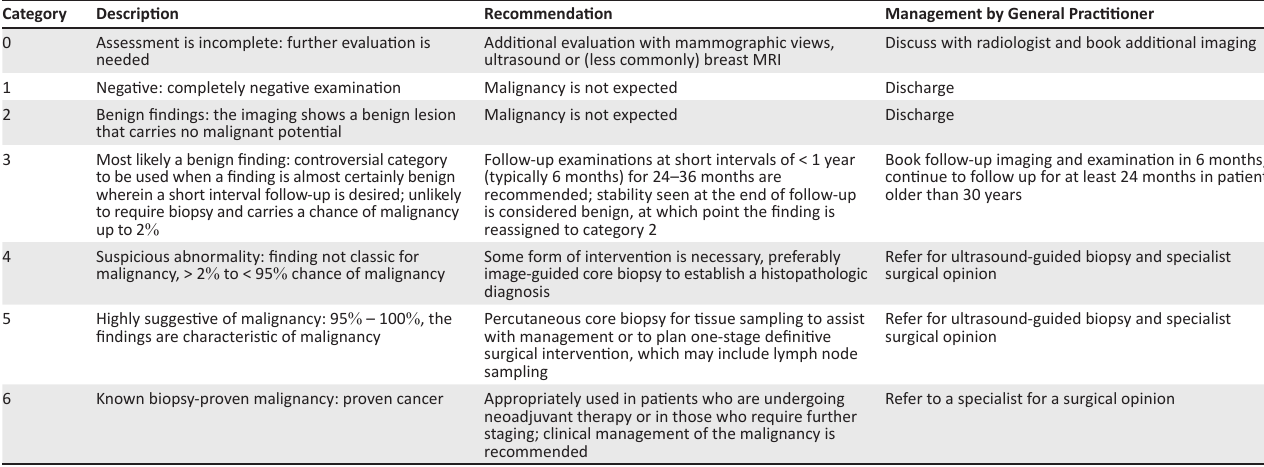
TABLE 1: The BI-RADS 5th edition: Assessment categories and recommendations. Category Description